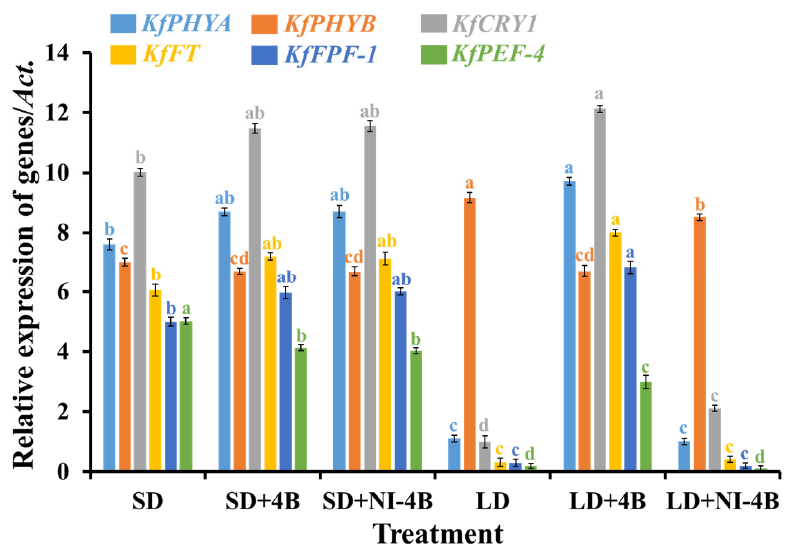
Figure 9. The effects of the supplementary and night-interrupting 10 µ mol · m − 2 · s − 1 PPFD B light on the gene expression levels in kalanchoe ( Kalanchoe blossfeldiana ‘Rudak’), after 60 days of exposure to the photoperiodic light treatments. Vertical bars indicate the means ± standard error ( n = 6). Different lowercase letters indicate significant separation within treatments by the Duncan’s multiple range test at p ≤ 0.05. (See Figure 2 for details on the photoperiodic treatments with B light; see Table 1 for details of genes).